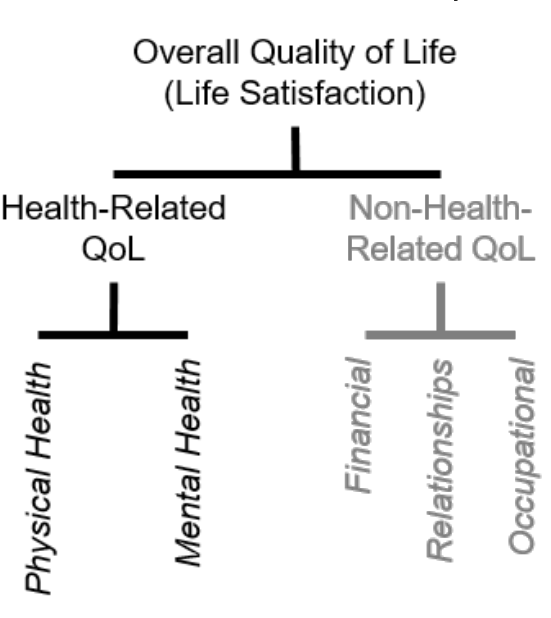
Figure 3-1. Hierarchical Structure of Quality of